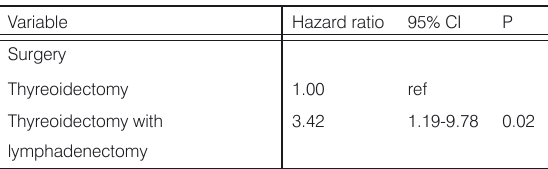
Table 3. Prognostic factors on long term survival of MTC patients (multivariate